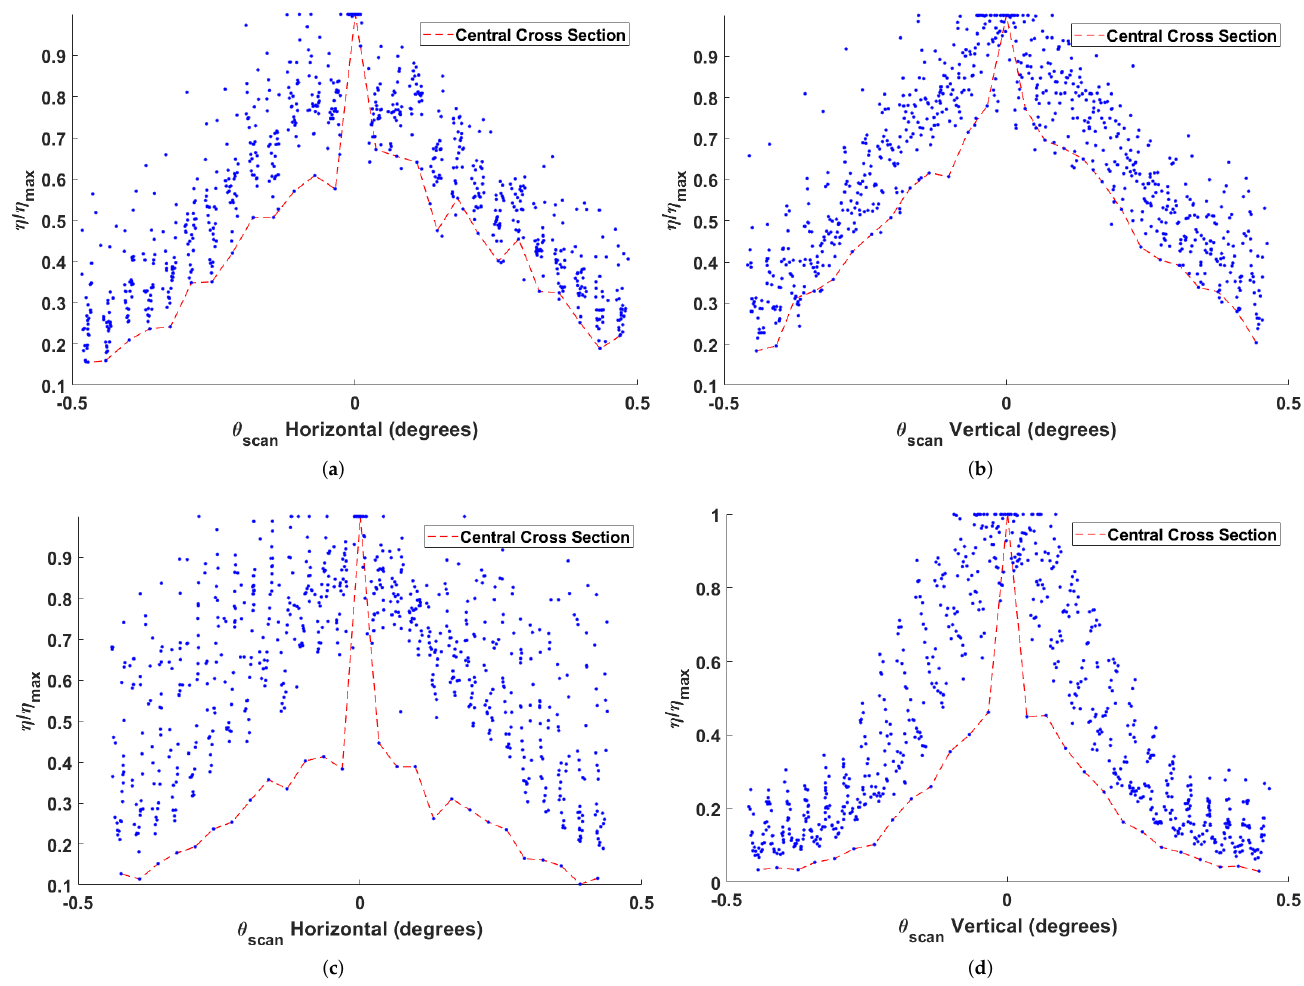
Figure 6. Scatterplot views of enhancement along the horizontal and vertical cross sections of Figures 4 and 5, normalized to each cross section’s maximum central enhancement. The metal sample’s quasi-linear decrease for both horizontal and vertical scans is shown in ( a , b ). The paint sample’s decrease is shown in ( c , d ). In each scatterplot, the profile of the cross section passing through the overall center maximum is